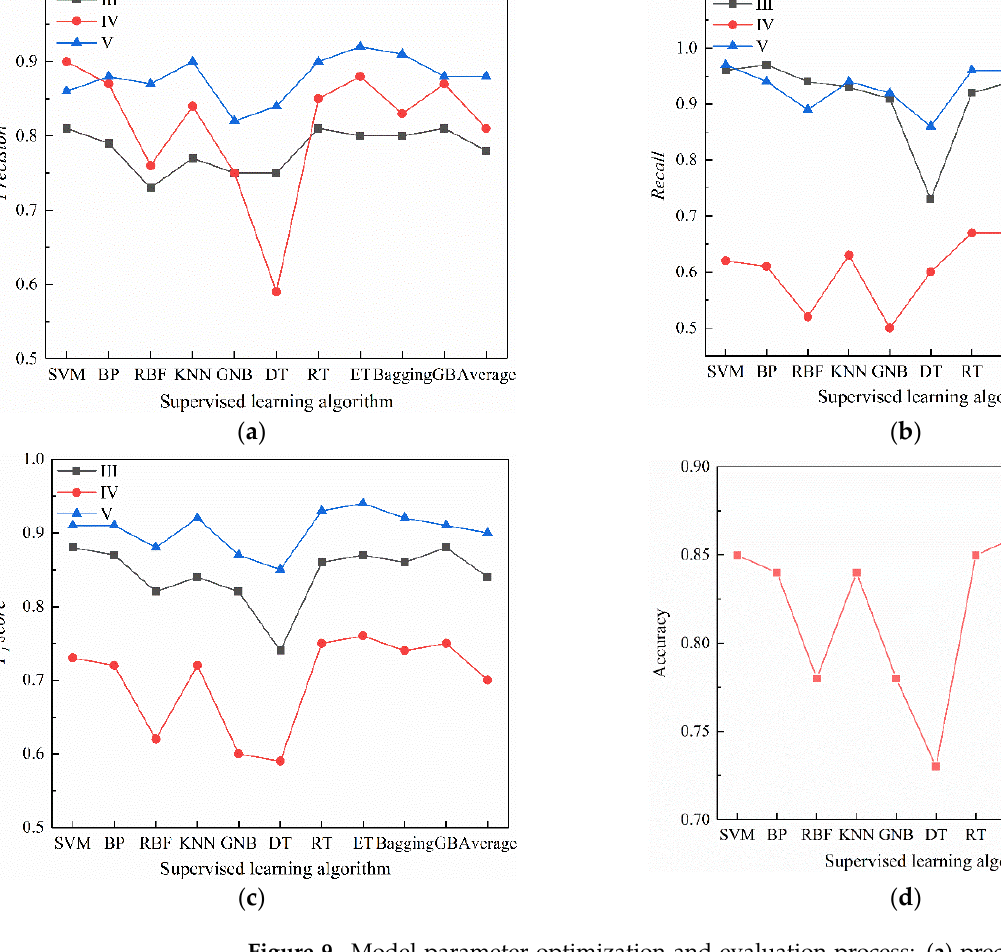
Figure 9. Model parameter optimization and evaluation process: ( a ) precision; ( b ) recall; ( c ) F 1 ; ( d ) accuracy. Table 7. Performance of the intelligent surrounding rock